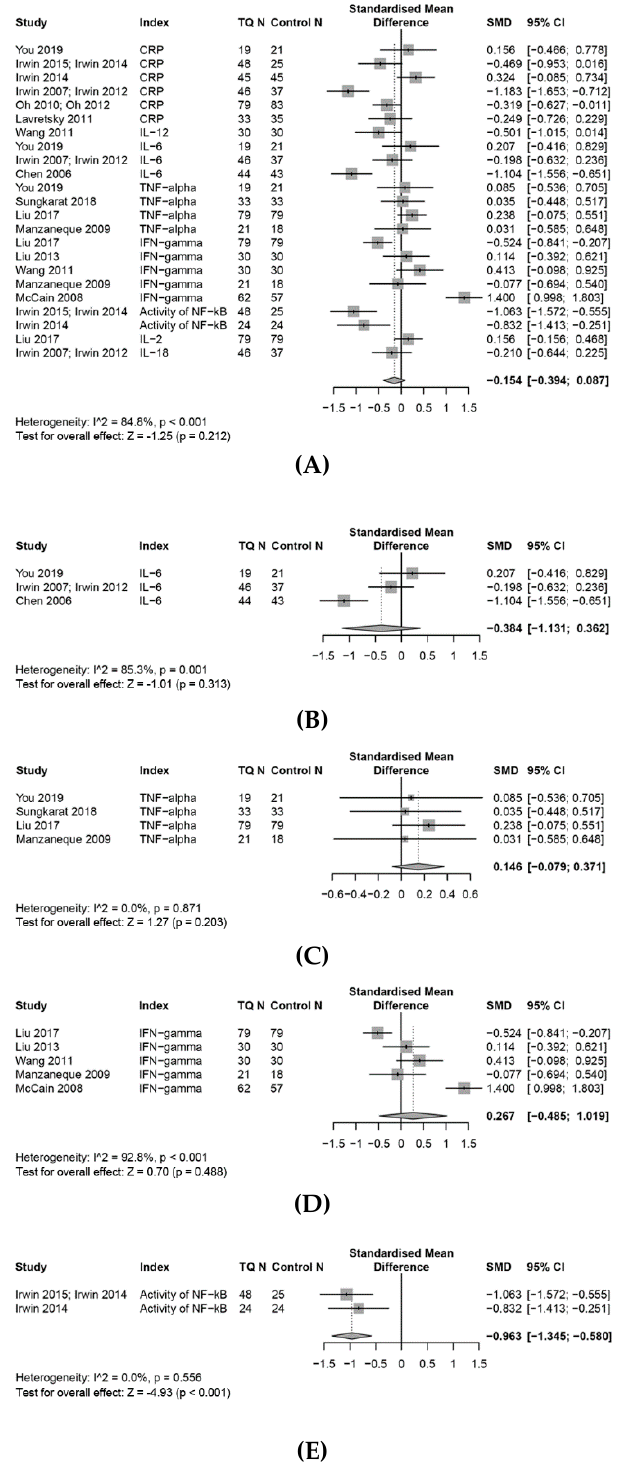
Figure 5. Forest plot for random-e ff ects meta-analysis of the e ff ects of TQ on the inflammation response. ( A ): The e ff ects on the inflammation response, ( B ): the e ff ects on the levels of IL6, ( C ): the e ff ects on the levels of TNF- α , ( D ): the e ff ects on the levels of IFN- γ , ( E ): the e ff ects on the activity of NF- κ B.